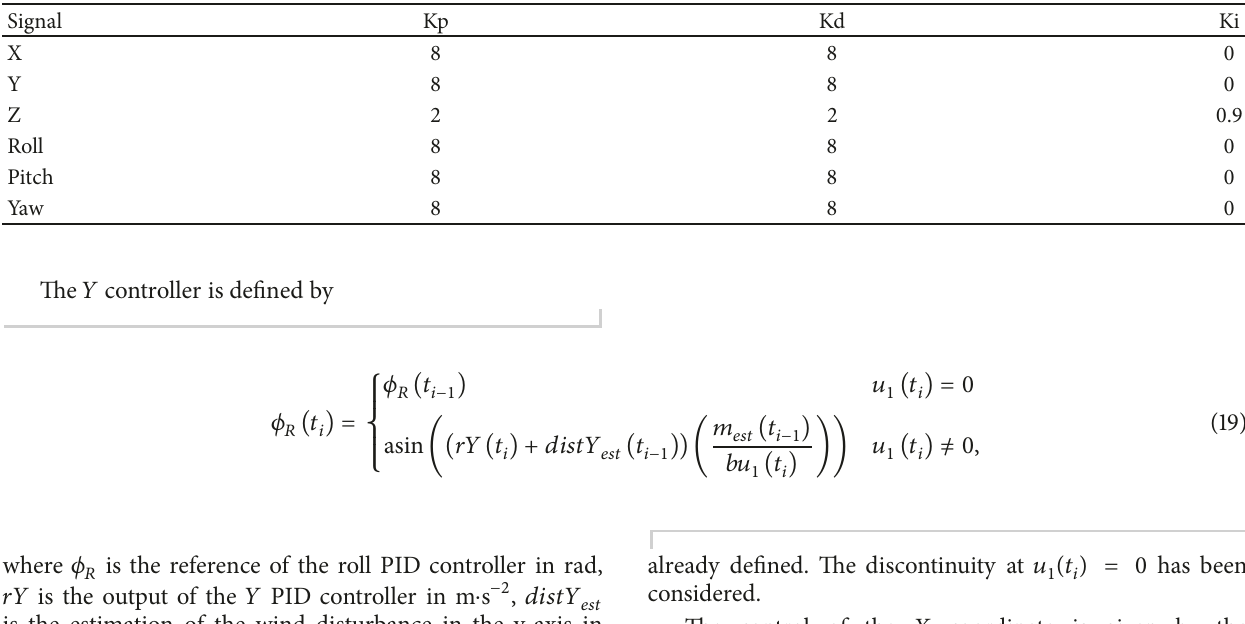
Table 2: PID parameters for each